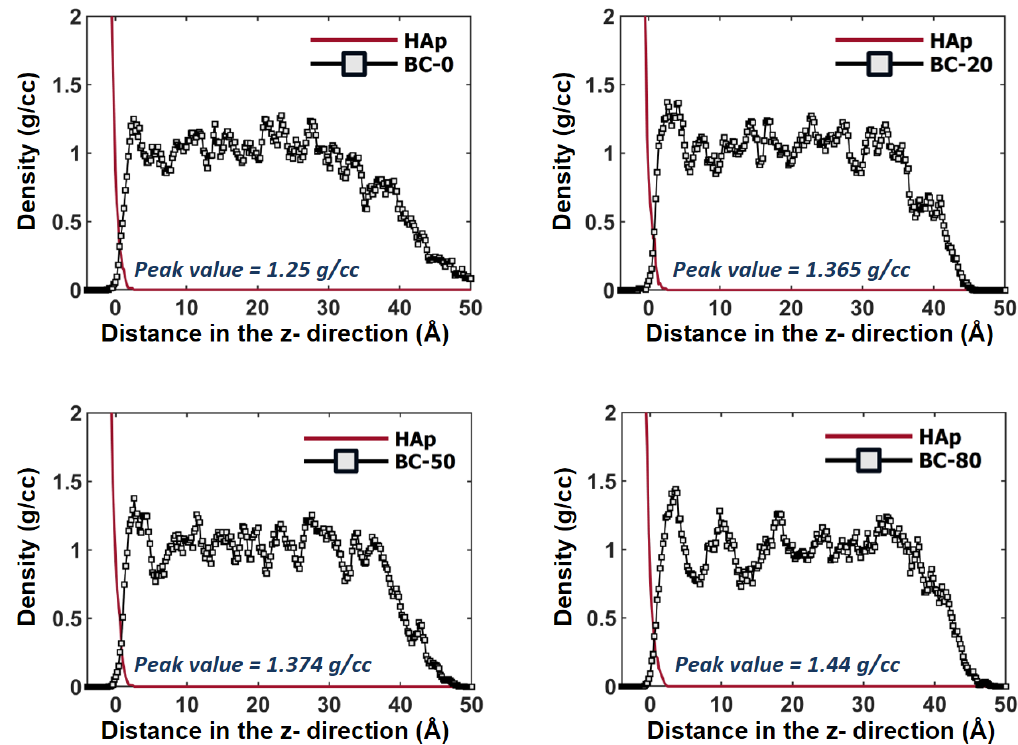
Figure 5. Density distributions for the HAp/BC bilayer models. The density profiles of the HAp substrate and the BC were described independently.